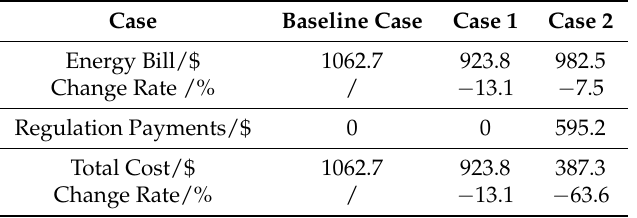
Table 2. Comparison of costs (one day) in the different